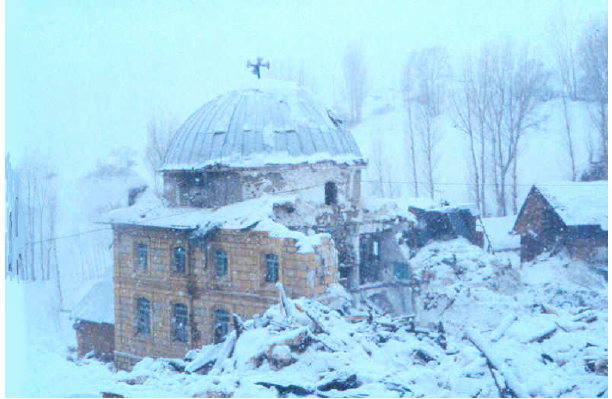
Fig. 4. Destroyed mosque due to 1993 avalanche event in Üzengili